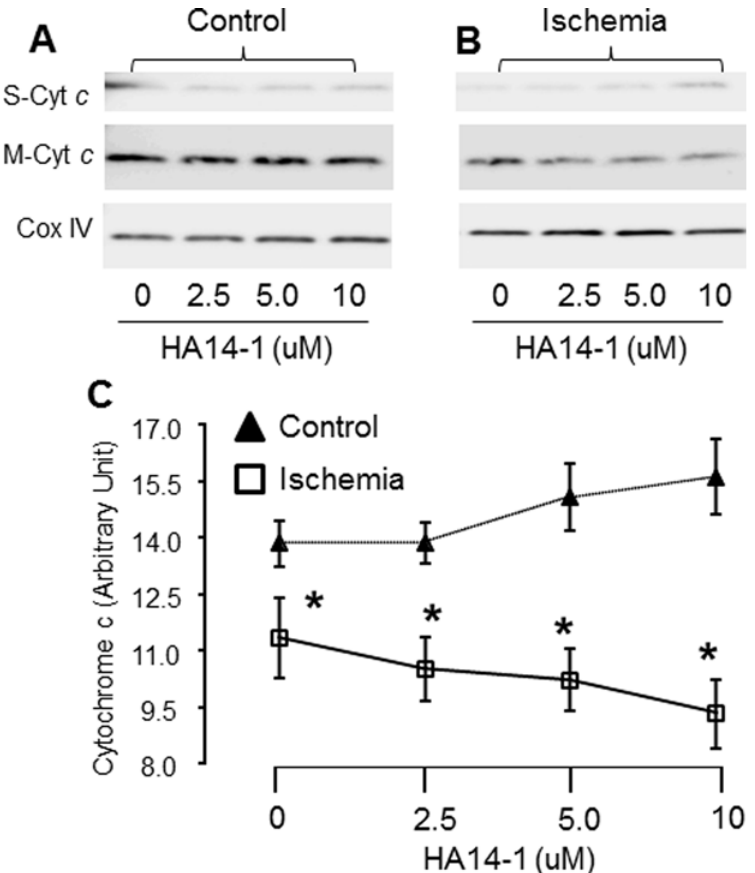
Fig 4. The effect of bcl-2 inhibition on cytochrome c content in control and ischemia-damaged mitochondria. Panel A: A representative image shows that titration of HA14 – 1 leads to decreased cytochrome c content in ischemia-damaged SSM with a corresponding increase in supernatant in a dose- dependent manner. Panel B: The ratio of intensity of cytochrome c to the intensity of subunit 4 of cytochrome oxidase. The decreased cytochrome c content in ischemia-damaged mitochondria compared to control in the absence of HA14 – 1, suggests that ischemia already leads to partial cytochrome c loss before mitochondria are isolated from ischemic hearts. The further decrease in cytochrome c content in HA14 – 1 treated ischemic mitochondria indicates that inhibition of bcl-2 can lead to further release of cytochrome c into supernatant (Mean ± SEM; * p < 0.05 vs. corresponding